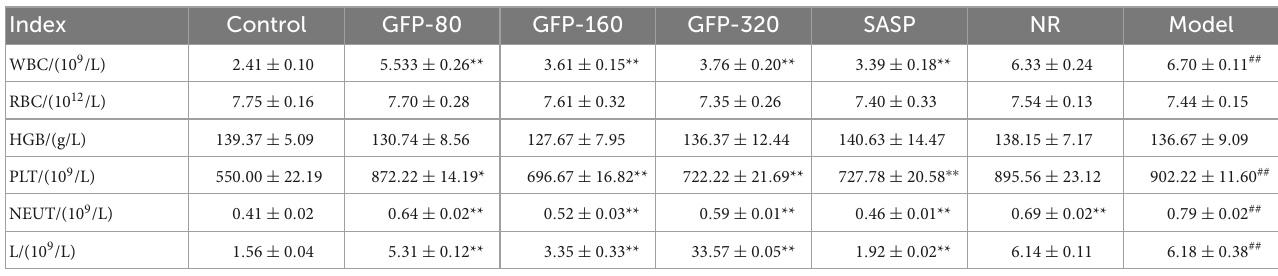
TABLE 4 Detection of blood routine indices in